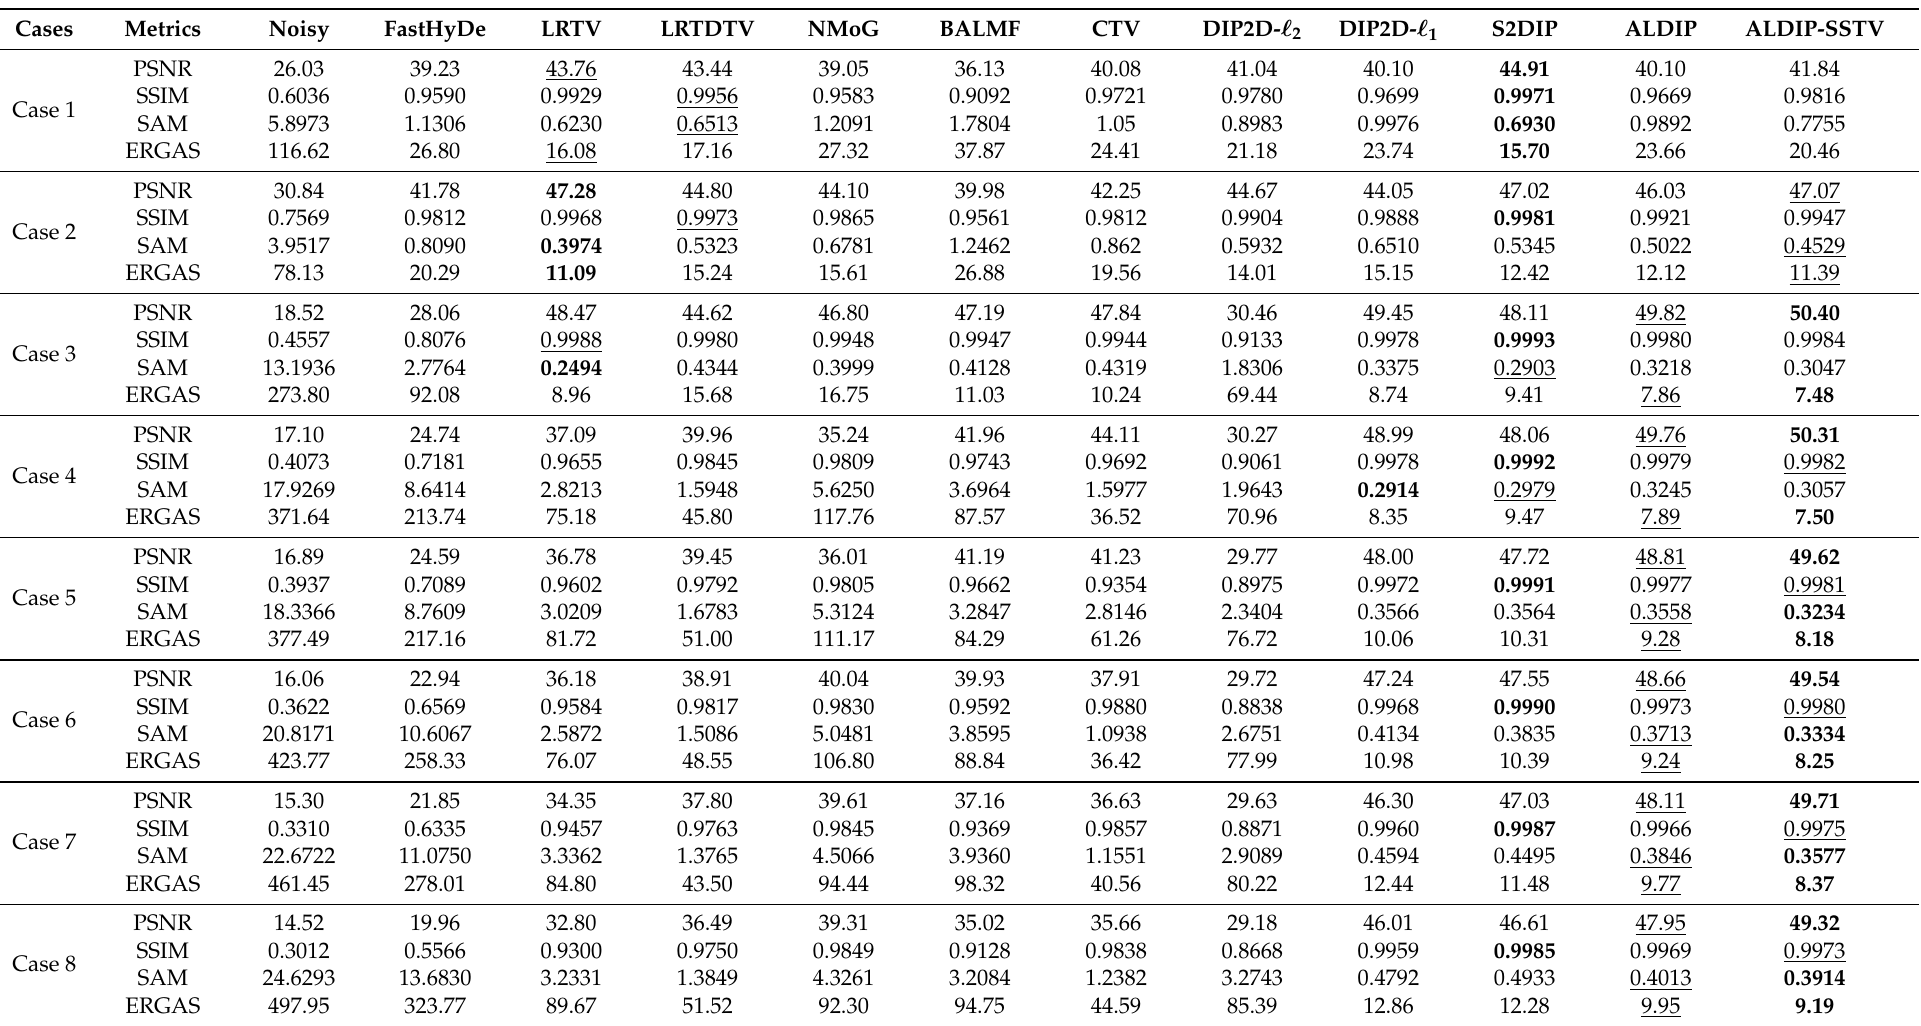
Table 2. The metrics of a synthetic data experiment on HSI dataset Indian Pines. The optimal values are indicated in bold and the second-best values are